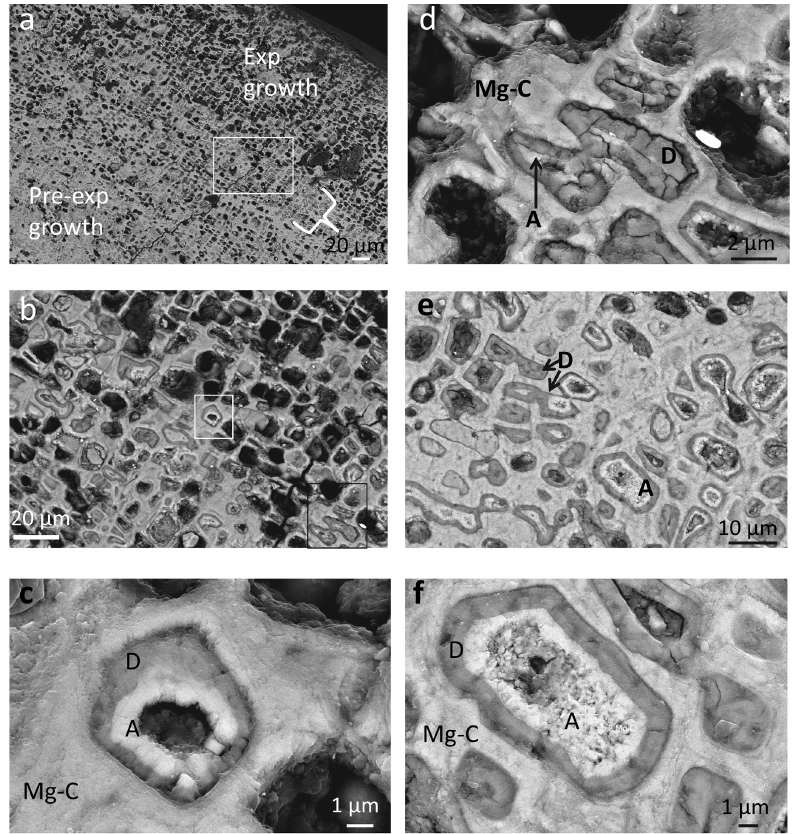
Figure 7. SEM (BSE) of Control P. onkodes (AC4). (a) Overview of experimental growth, pre-experimental growth and transition zone (bracket). Cells at the surface do not have dolomite. White box enlarged in (b) . (b) Cells in experimental growth have no dolomite infill. Cells below experimental growth have dolomite lining the cells but the centres are in-filled with aragonite. White box enlarged in (c) , black box enlarged in (e) . (c) Close up of cell infill by aragonite within the dolomite lining. (d) Dolomite lined cell in transition zone with aragonite infill. (e) Patch of crust below experimental growth with aragonite infill. (f) Close up of dolomite-lined cell with aragonite infill. Scale bars: (a) and (b) = 20 microns, (c) and (f) = 1 micron, (d) = 2 microns, (e) = 10